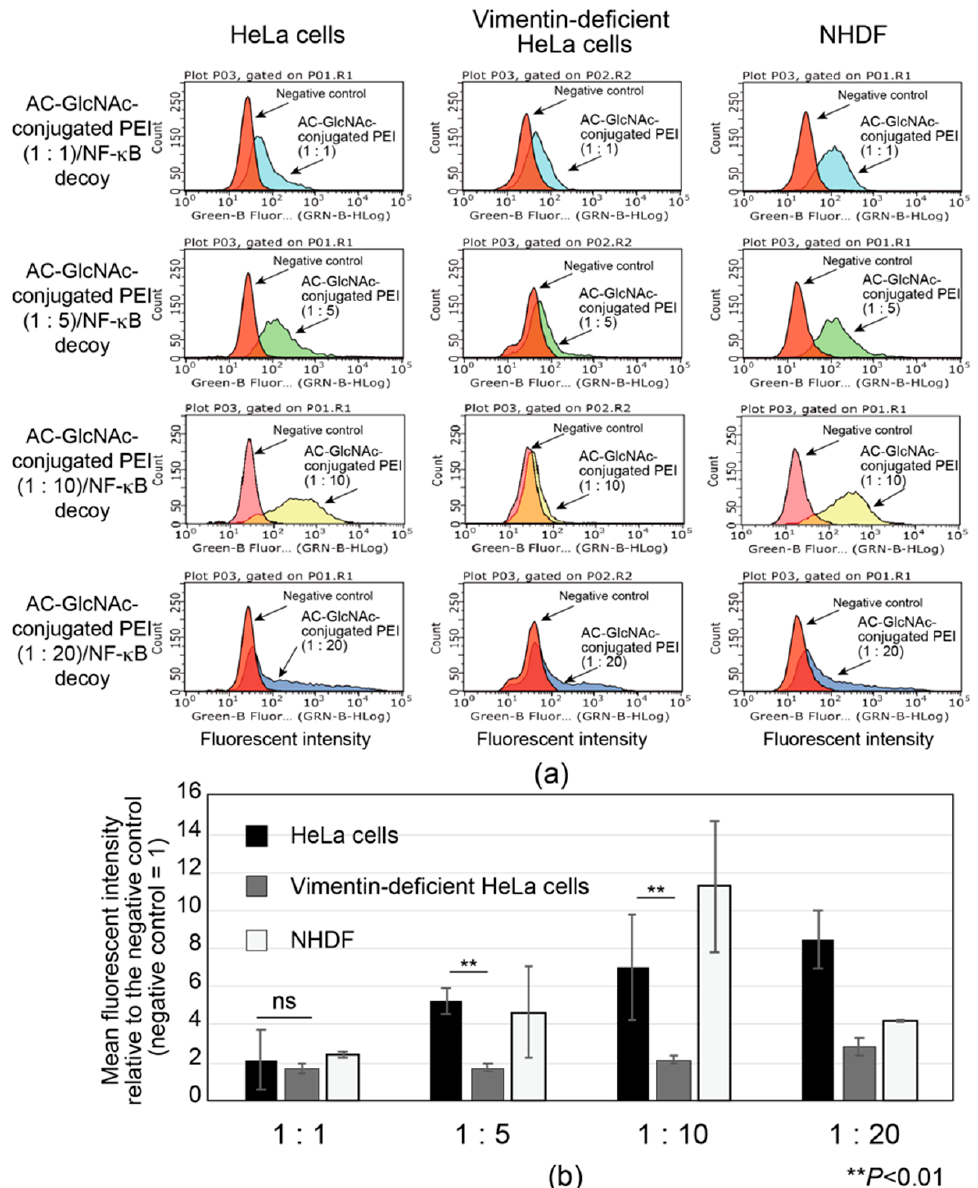
Figure 5. Flow cytometric analysis of the interaction between AC-GlcNAc-conjugated polyethyleneimine (PEI) and NF- κ B decoy oligonucleotide (ODN) complexes and cervical cancer cells (HeLa cells), vimentin-deficient HeLa cells, and normal human dermal fibroblasts (NHDFs). ( a ) Flow cytometric charts of these interactions. ( b ) Mean fluorescent intensity of the interaction between these complexes and each cell type. Values are indicated based on fluorescence intensity of the negative